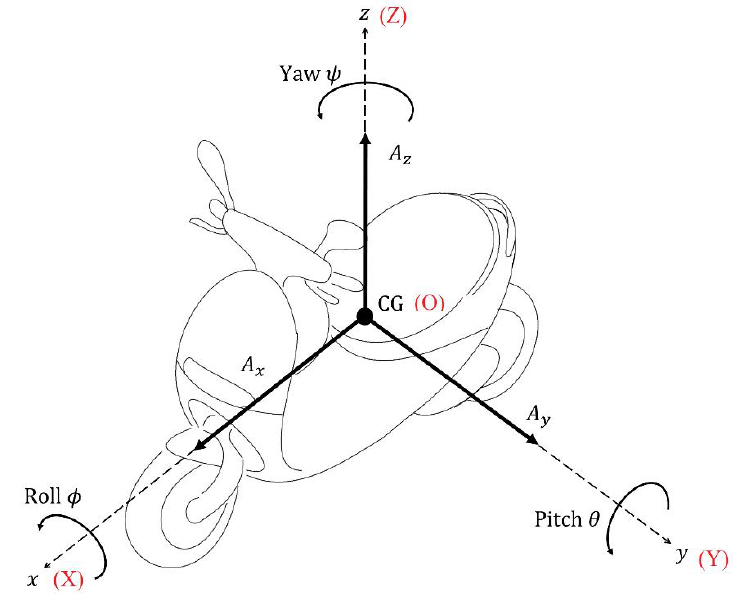
Figure 1. Vehicle coordinate and parameters.